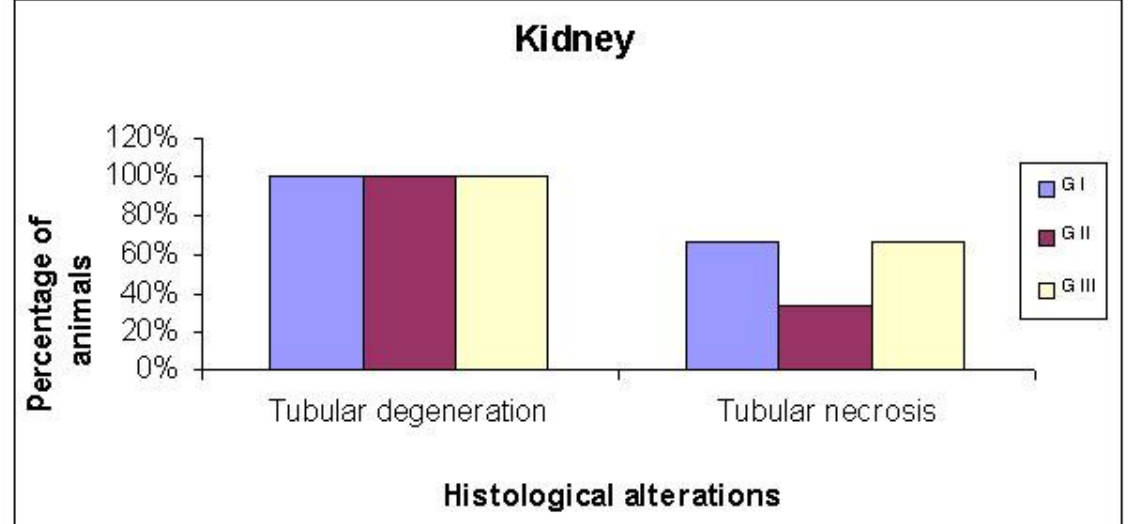
Figure 7. Percentage of animals that developed renal